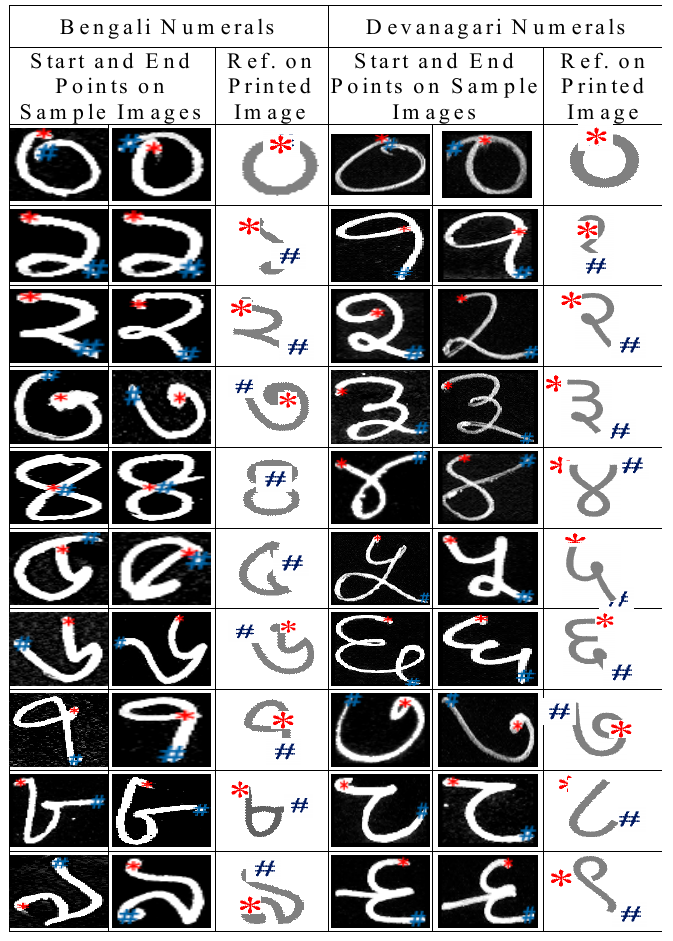
Figure 4. Numeral-wise start and end points marking on sample images; and start and end reference points marking on printed numerals.